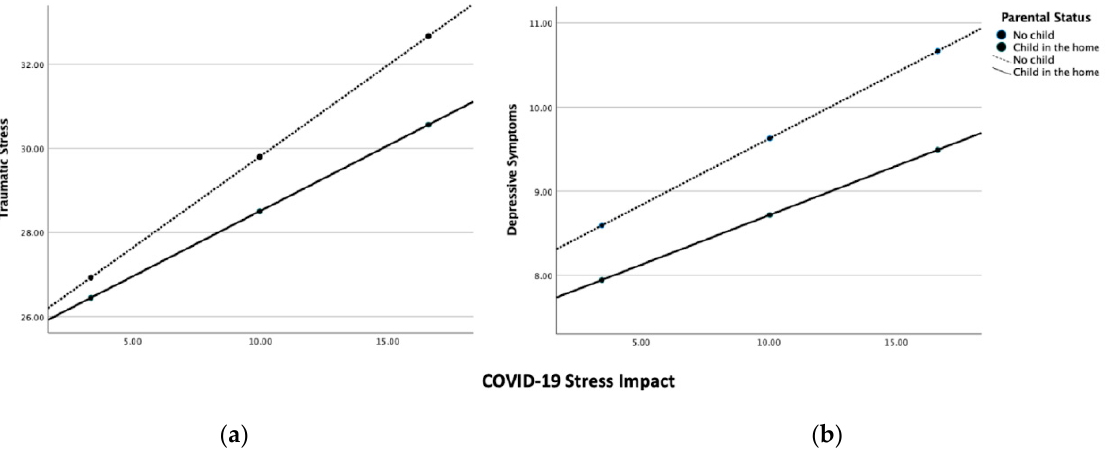
Figure 1. COVID-19 stress impact predicting traumatic stress and depressive symptoms by parental status. ( a ) First figure to the left showcases the association between COVID-19 stress impact with traumatic stress by parental status; ( b ) the second figure to the right showcases the association between COVID-19 stress impact with traumatic stress by parental status.